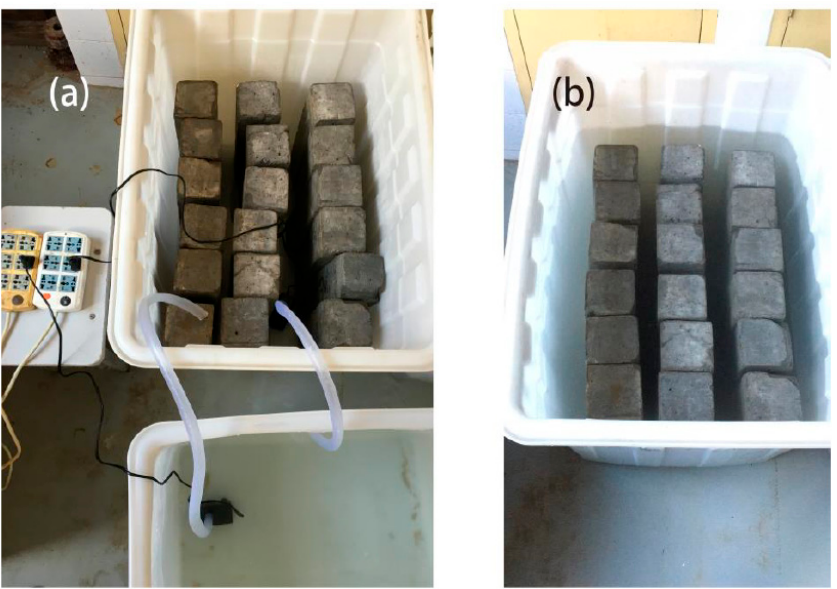
Figure 2. Curing methods of specimens; ( a ) schematic of the setup of the wet/dry cycles, ( b ) schematic of the setup of the